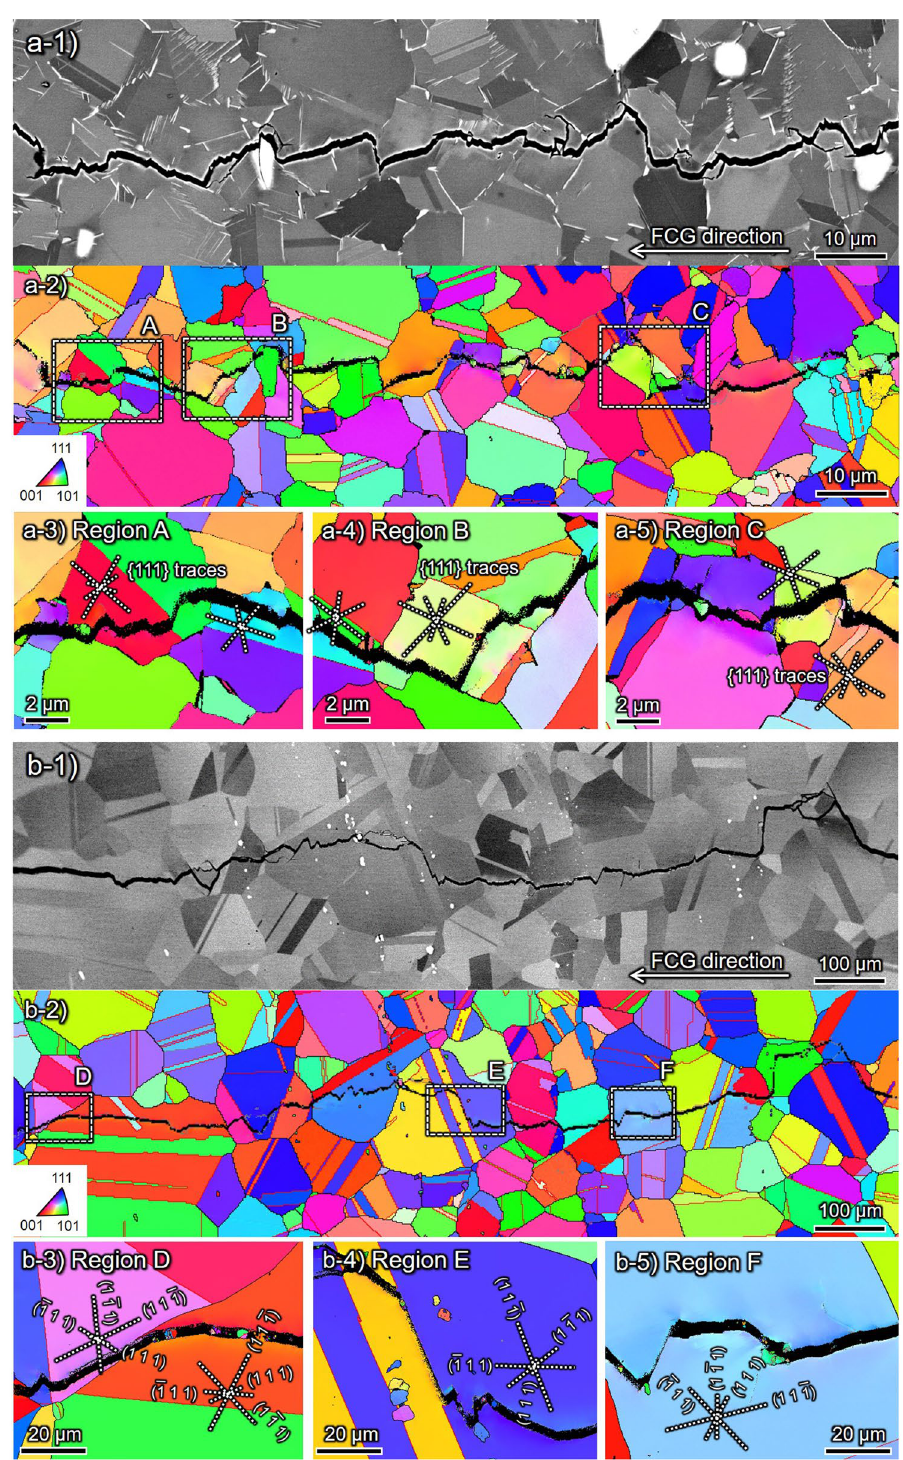
Figure 5. Crack path crystallography of ( a ) δ-FG and ( b ) CG in the presence of H at Δ K = 10 MPa m 1/2 : ECC images for overall aspects are in ( a-1 ) and ( b-1 ). Inverse pole figure (IPF) maps with respect to the loading axis at the regions A–C for δ-FG and D–F for CG are in ( a-3–a-5,b-3–b-5 ) with {111} plane